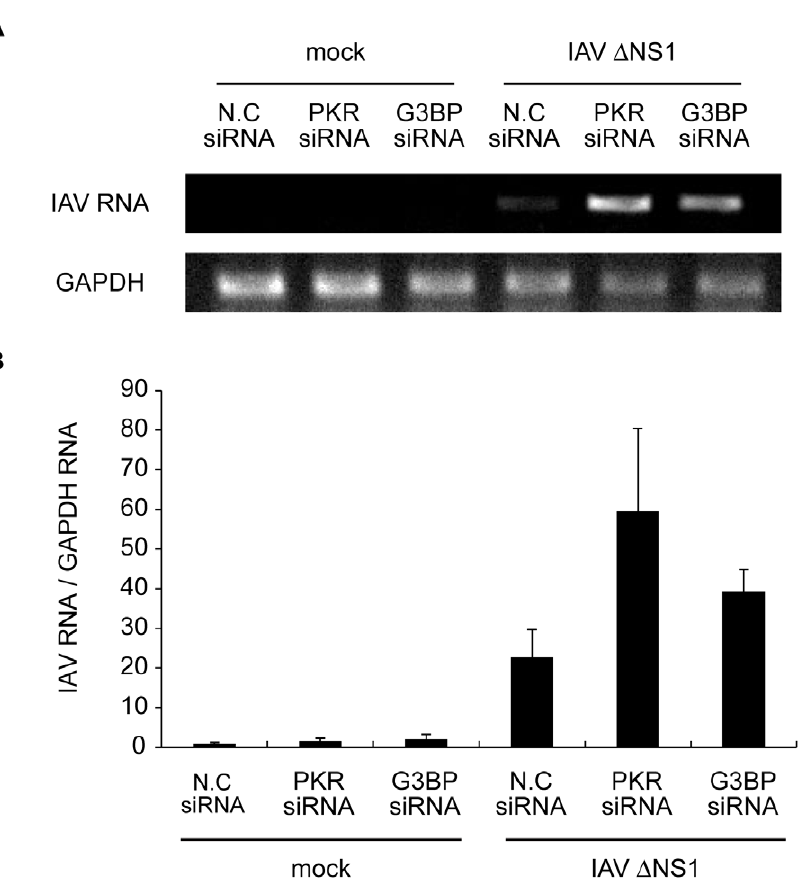
Figure 7. Inhibition of avSG formation enhanced IAV viral replication. HeLa cells were transfected with control siRNA (N.C) or siRNA targeting human PKR mRNA or G3BP. At 48 h after transfection, cells were mock-treated or infected with IAVA¨NS1 for 24 h. The expression levels of IAV RNA segment 3 and GAPDH mRNA were determined by RT-PCR ( top ). The IAV RNA expression patterns were quantified with LAS-1000 UV mini (Fujifilm, Japan) and normalized with GAPDH ( bottom ). Data are represented as the mean standard 6 error of the mean (SEM).